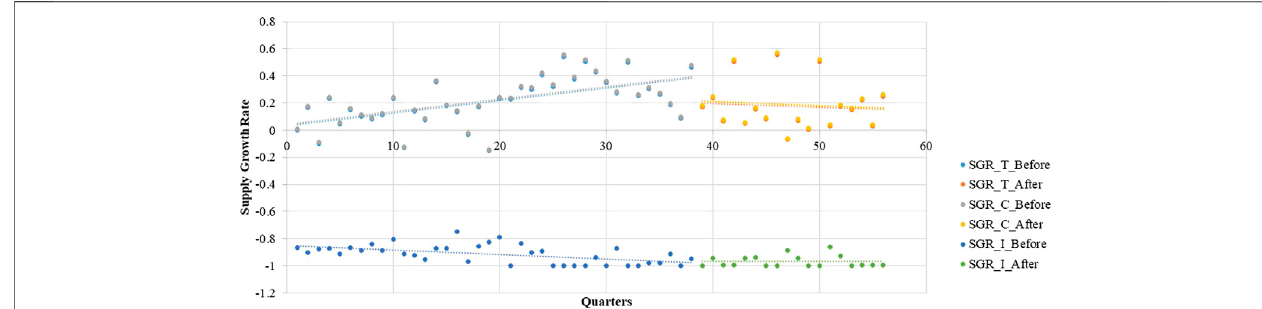
FIGURE 3 | Segmented regression model showing LPCMs ’ supply growth rates from 2005 to